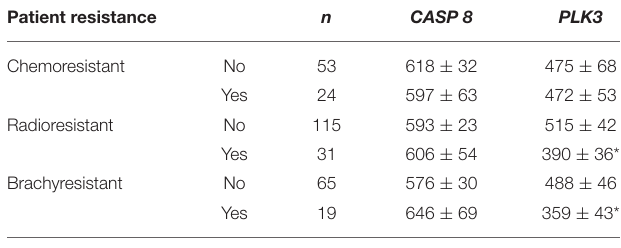
represent RNA-Seq Expectation-Maximization (RSEM) normalized expression values.